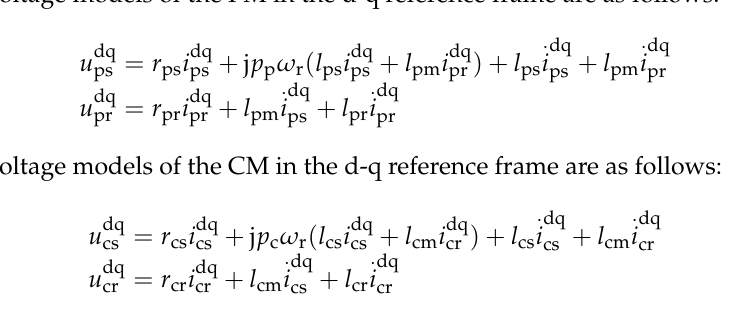
Figure 2. The relationship between the reference frames. ( a ) The relationship between the static stator three-phase reference frame and the static stator two-phase reference frame; ( b ) the relationship between the rotor three-phase reference frame and the rotor d-q reference frame; ( c ) the relationship between the rotor d-q reference frame and the arbitrary rotating m-t reference frame.